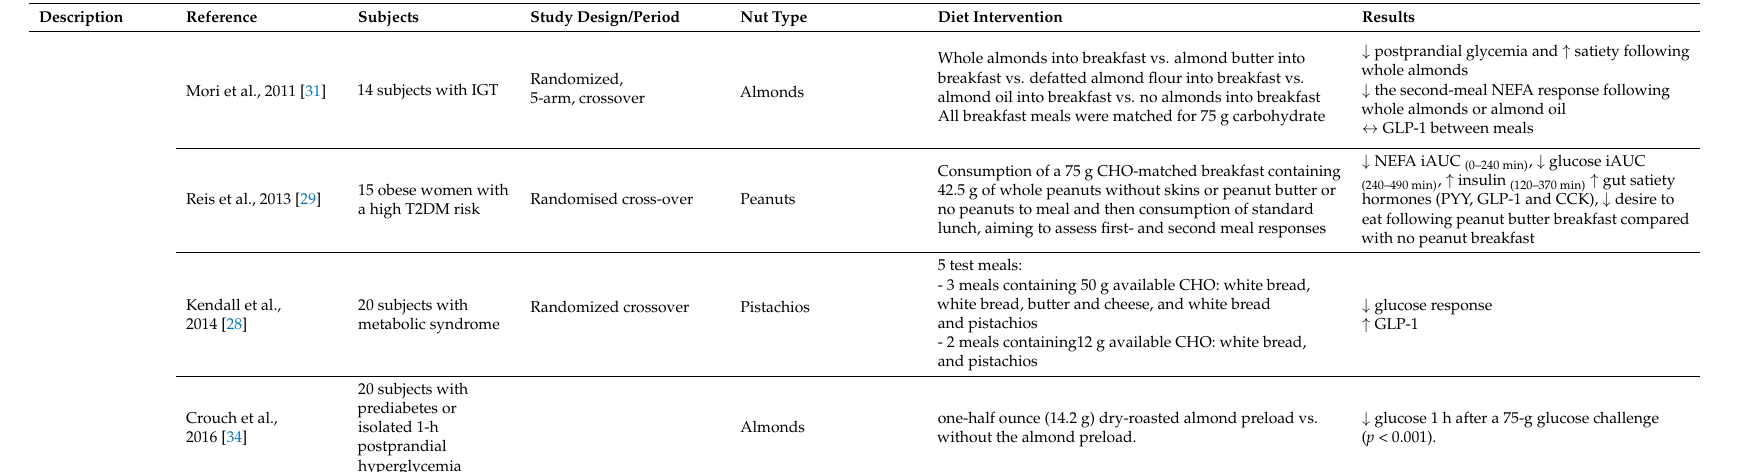
HOMA-B, homeostasis model analysis for beta-cell function; hs-CRP, high sensitivity C-reactive protein; iAUC, incremental area under curve; ICAM, intracellular adhesion molecule; LDL-C, low density lipoprotein; IGT, impaired glucose tolerance; IL-6, interleukin-6; MDA, malondialdehyde; MUFA, monounsaturated fatty acids; NEFA, non-esterified fatty acids; PYY, peptide YY; RCT, randomised controlled trial; SFA, saturated fatty acid; SOD, superoxide dismutase; TC, total cholesterol; TG, triglyceride; VCAM, vascular cellular adhesion molecule; ↑ , increase; ↓ , decrease; ↔ , no